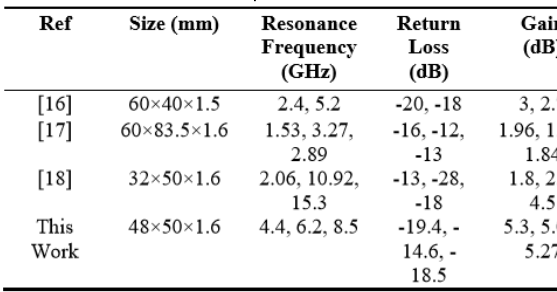
Table 1. Comparison with